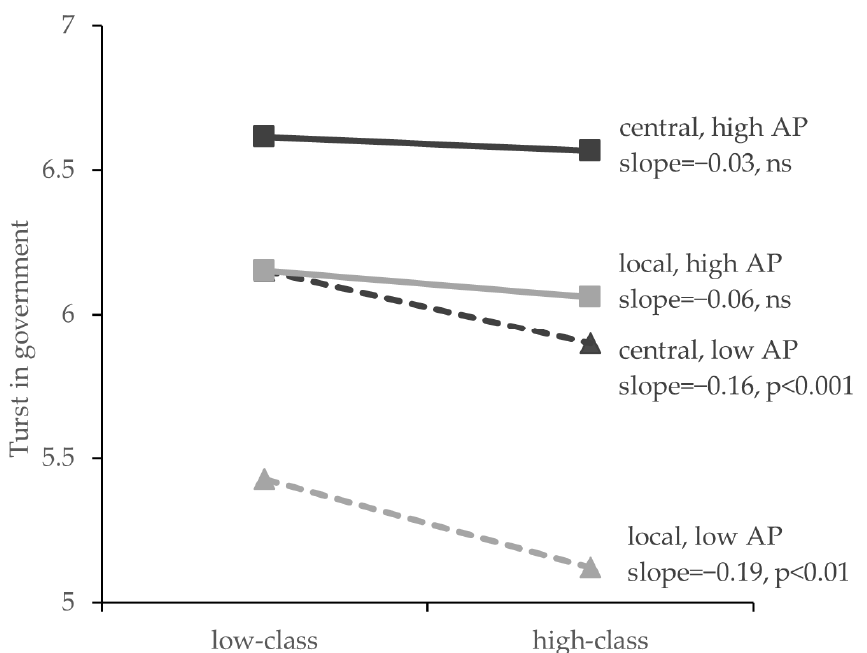
Figure 3. Moderating effect of authoritarian personality on the relationship between SES and trust in central and local government. Note: AP = authoritarian personality.